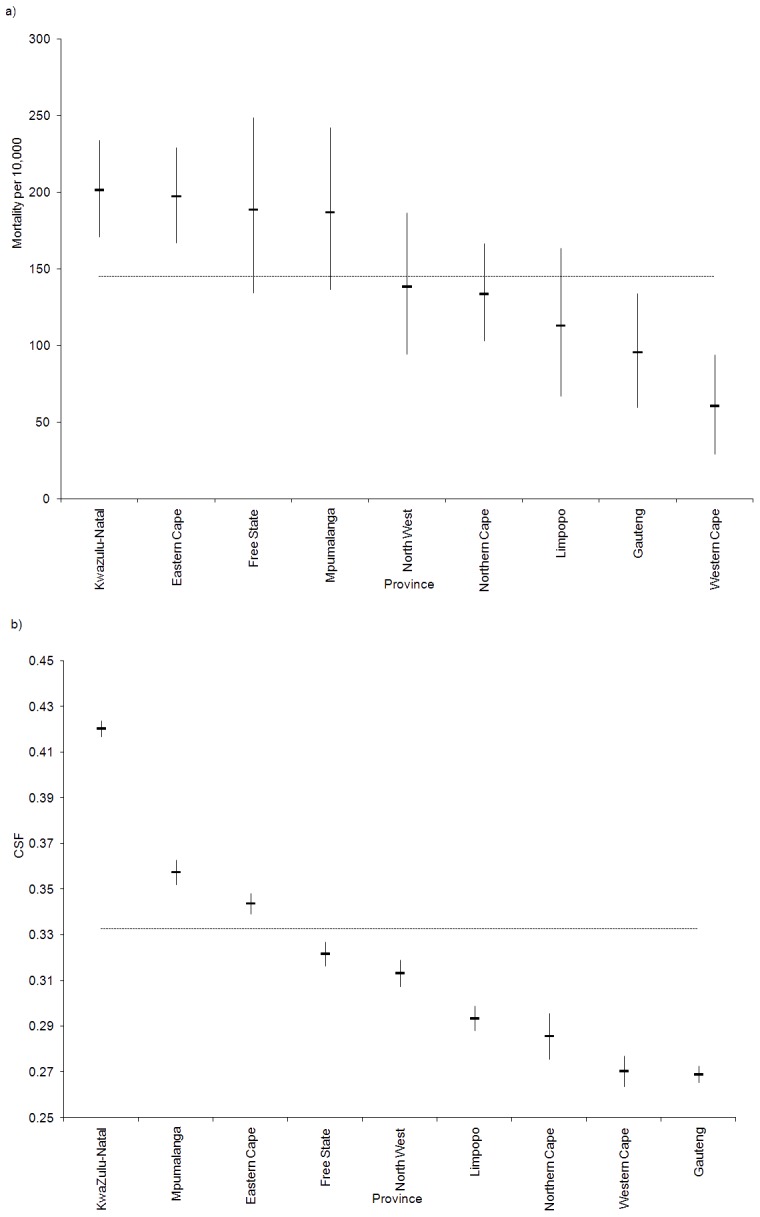
a) Descending all-cause adult mortality proportions (survey) and b) cause-specific fractions attributed to infectious causes (vital registration) at the secondary level (province), South Africa, 2007.[CSF = cause specific fraction].